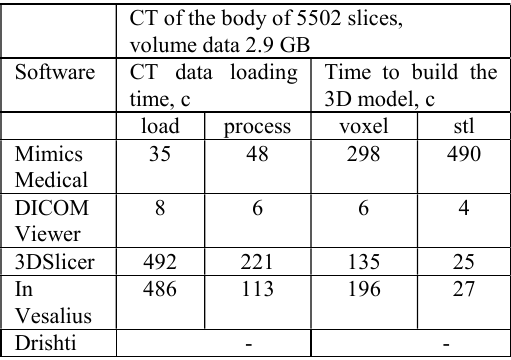
Table 3 . Comparison of the time of processing and conversion of tomographic data, a difficult